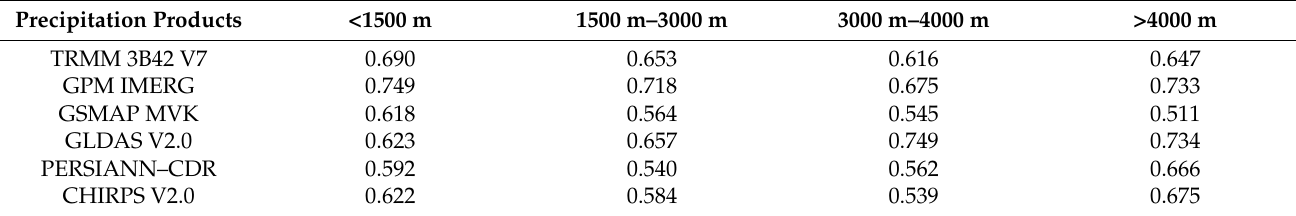
Table 6. CC between different elevation intervals.